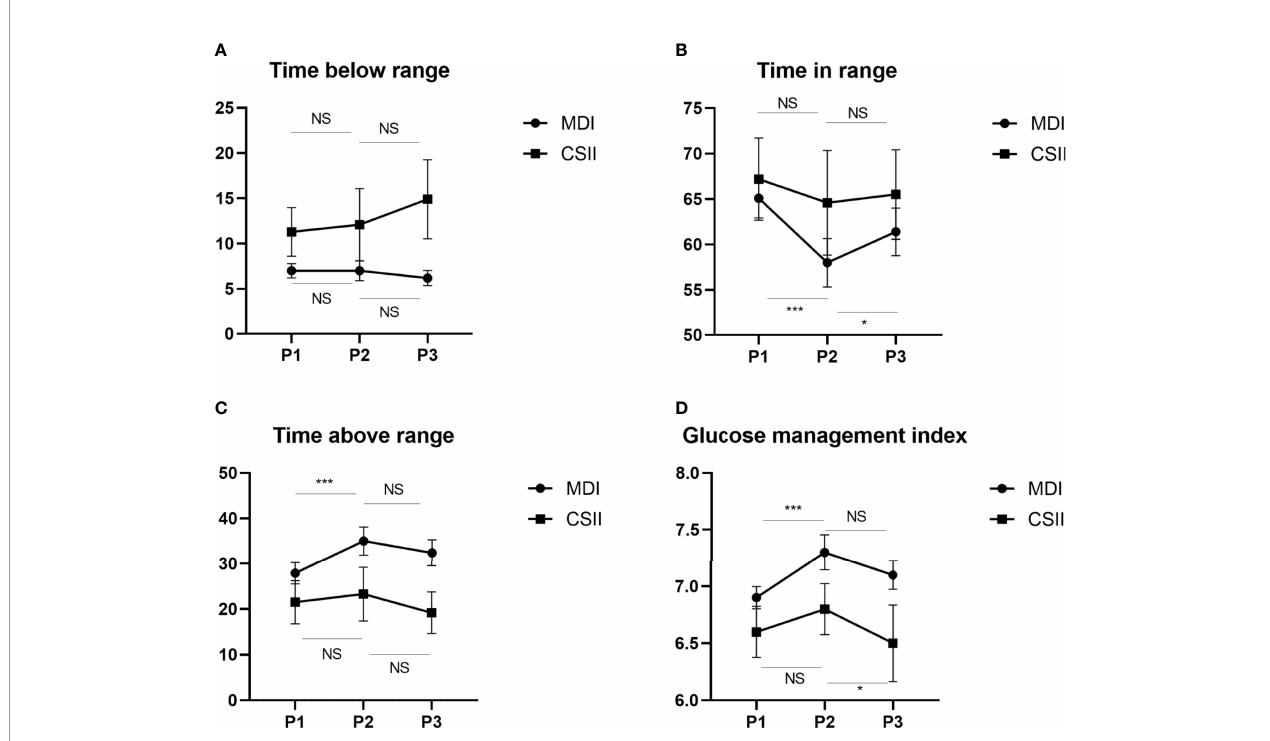
FIGURE 2 | Changes in glycemic indices TBR (A) ,TIR (B) ,TAR (C) and GMI (D) before, during and after the Chinese New Year public holiday in two insulin infusion subgroups. GMI, glucose management indicator; TIR, time in range; TAR, time above range; TBR, time below range, P1, the period before the Chinese New Year public holiday; P2, the period during the Chinese New Year public holiday; P3, the period after the Chinese New Year public holiday. NS, not signi fi cant; *P < 0.05; ***P <